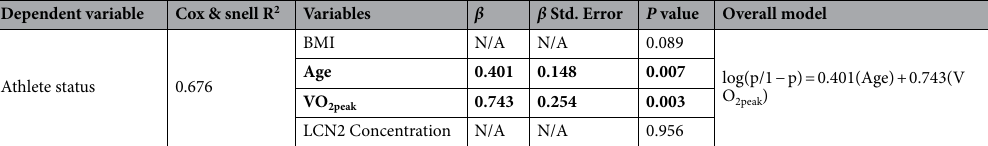
˙ V O 2peak maximal aerobic